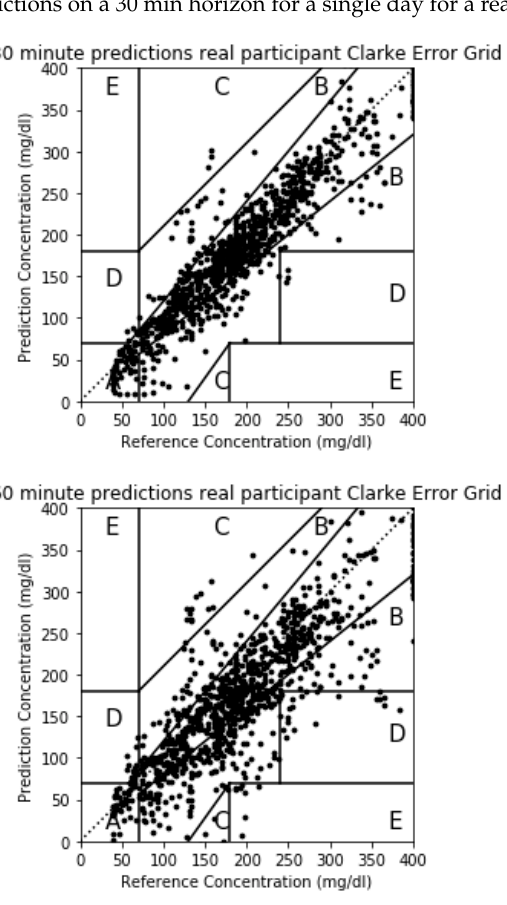
Figure 9. The 30 and 60 min horizon Clarke Error Grids for a real participant.